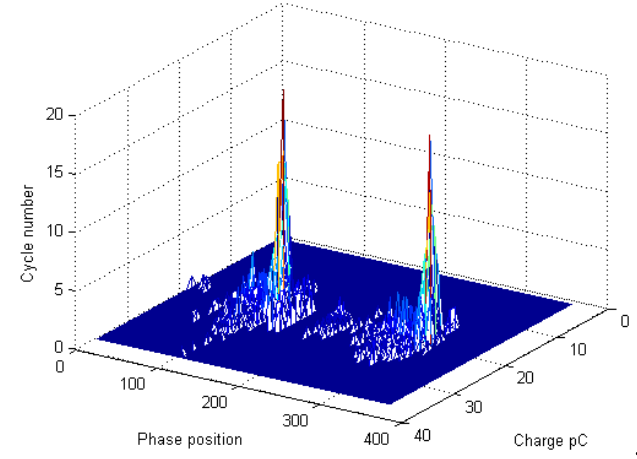
Figure 17. Normal operation of the equipment.